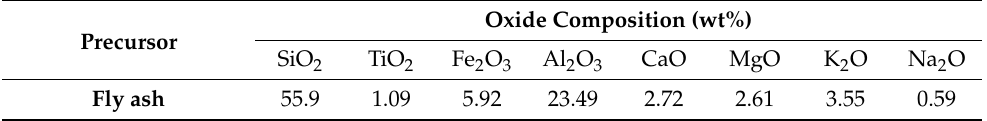
Table 1. Oxide composition of fly ash.